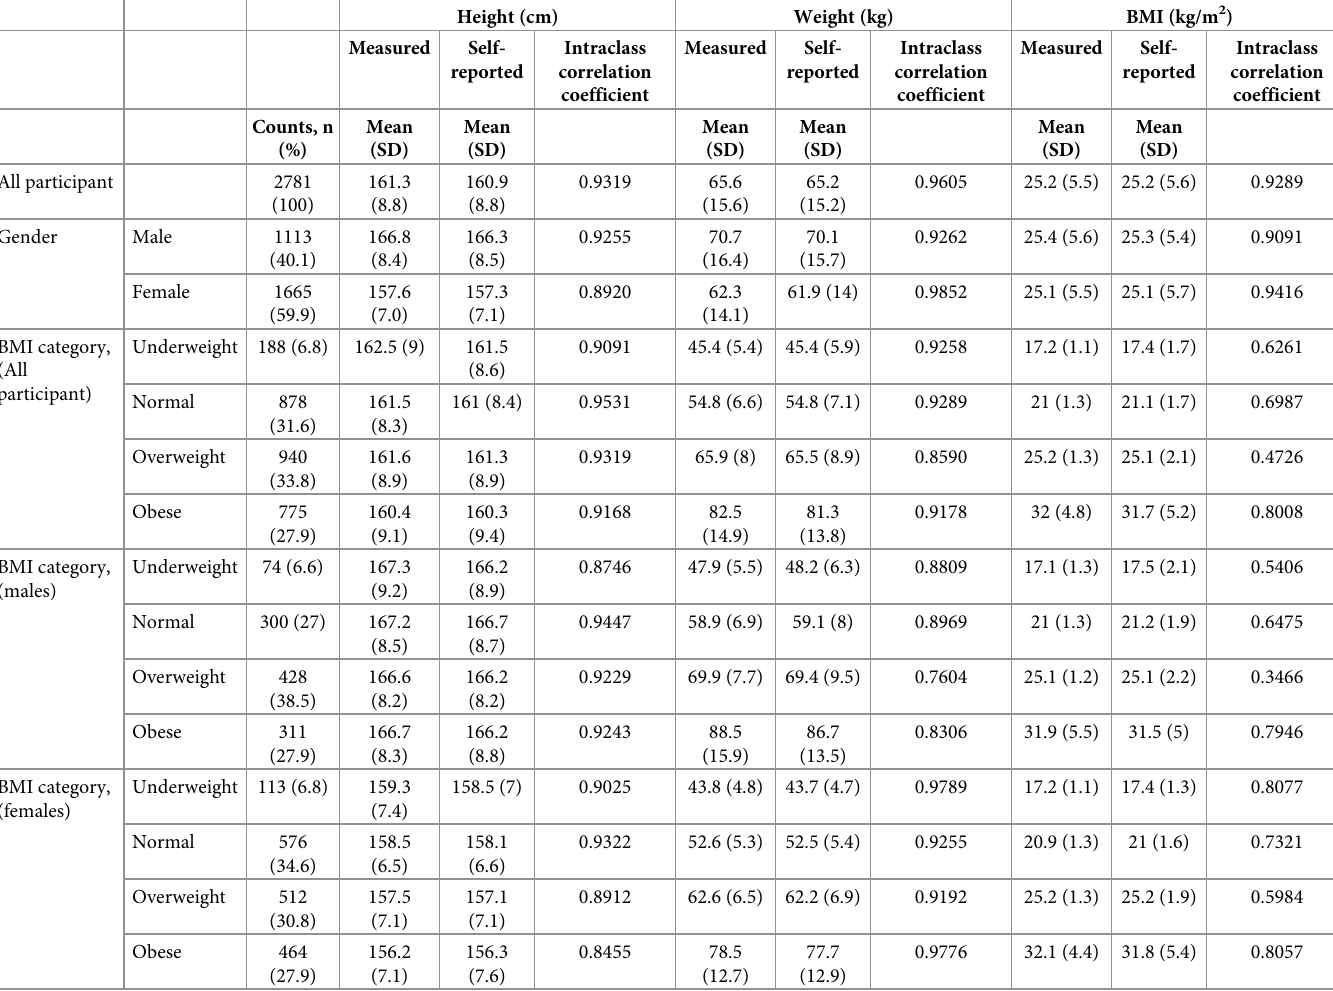
Table 2. Agreement between measured and self-reported values for height and weight in all participants, and stratified by genders and BMI